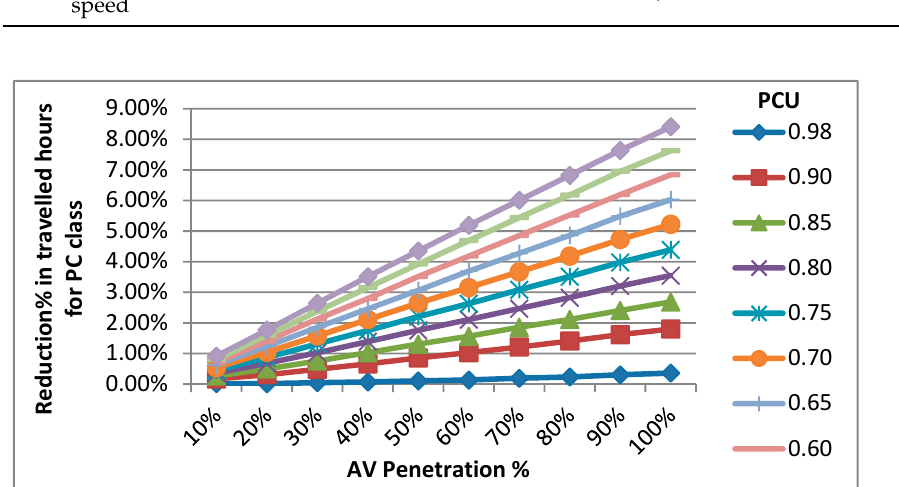
Figure 2. Reduction percent in traveled hours for passenger car class. AV spread in the traffic flow also reduces total daily delay significantly of the whole network model, reaching a reduction of 62,881 h for 100% AV penetration and 0.5 PCU equal to 37.87% of base scenario delay. Implementation of AVs with different factors has also increases mean network speed by 4.08%, reaching 45.20 km/h compared to 43.43 km/h in the base scenario. The results for delay and speed are shown in Figures 6 and 7,